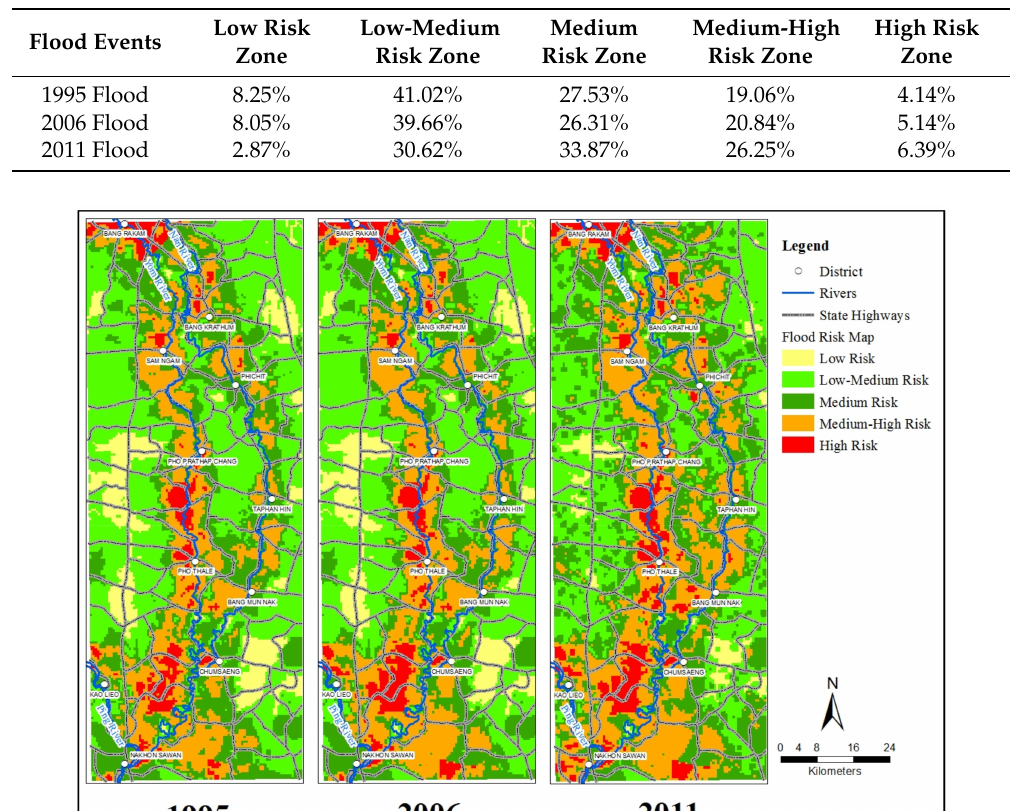
Table 4. Percentage of risk zones of the 1995, 2006, and 2011 floods in low-lying areas of middle CPRB.